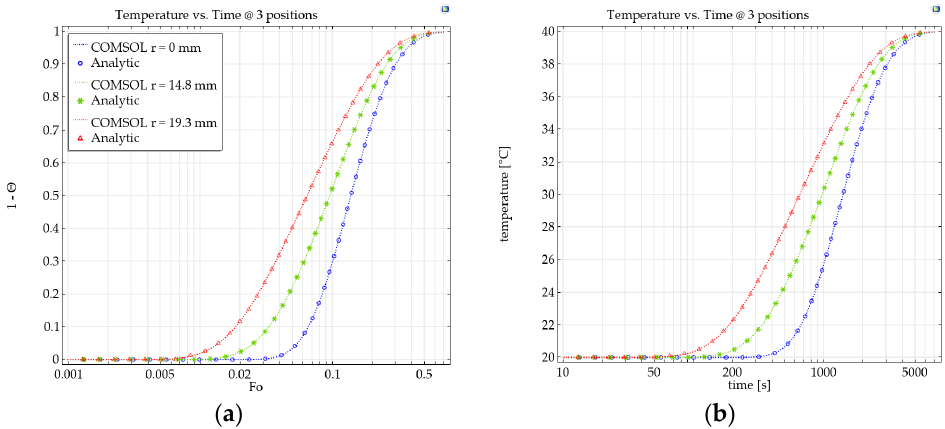
Figure 8. Comparison of simulated [12] and theoretical results in ( a ) non-dimensional form and ( b ) dimensional form.